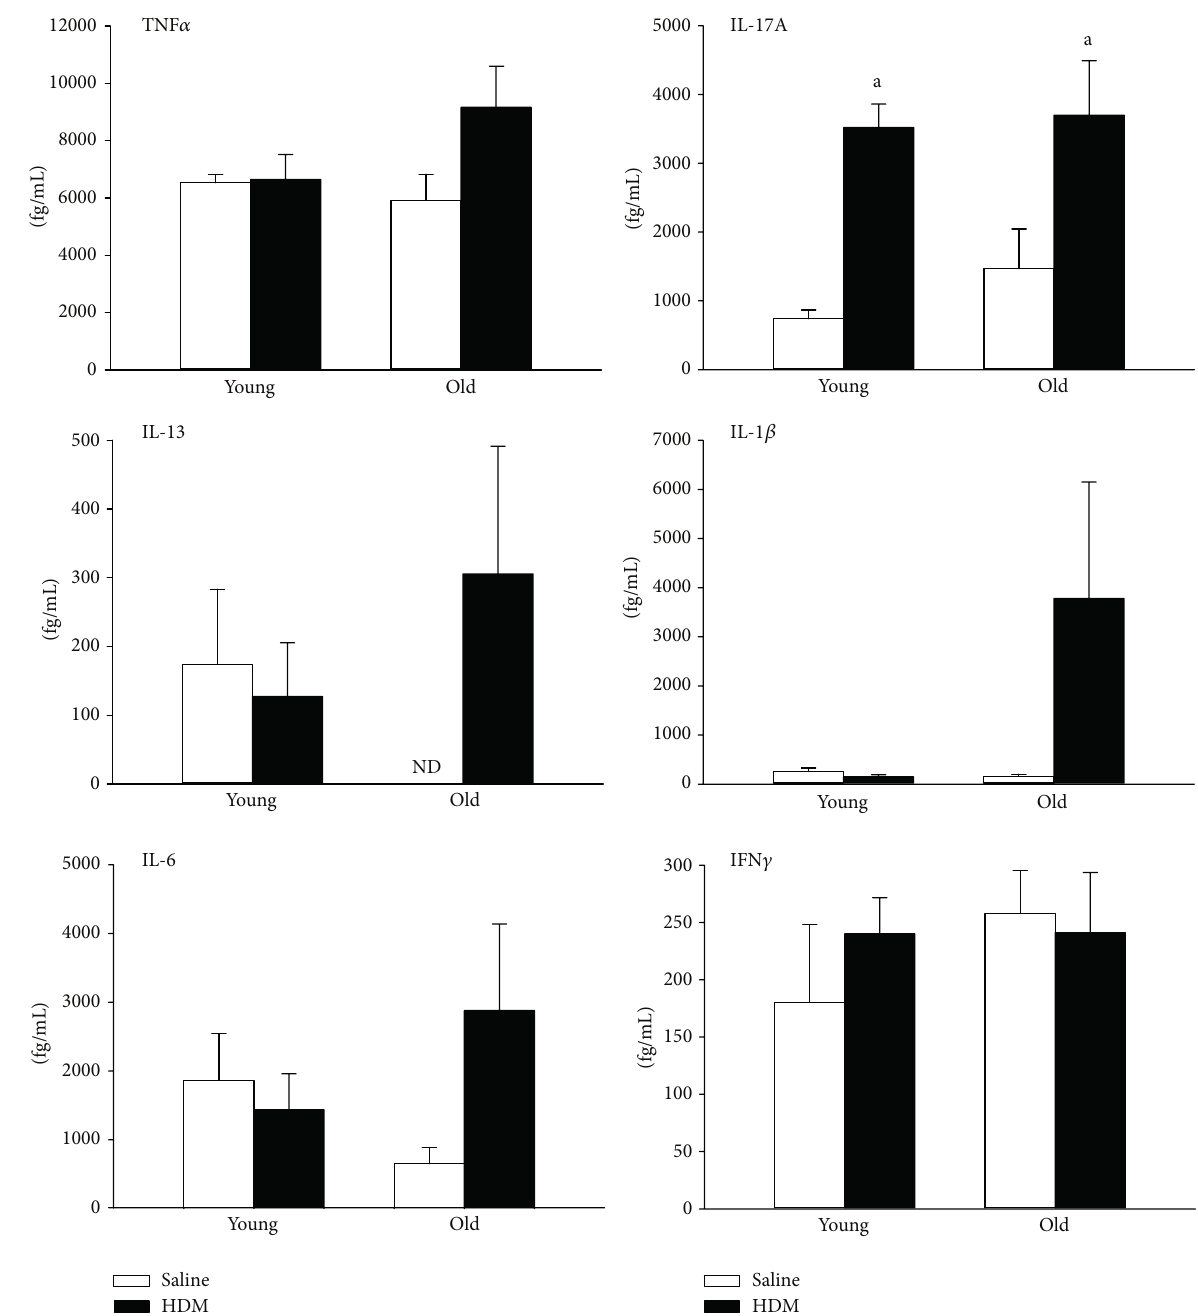
Figure 2: Expression of serum cytokines. Different serum cytokine concentrations were analyzed: TNF 𝛼 , IFN 𝛾 , IL-1 𝛽 , IL-6, IL-13, and IL- 17A. a: significant changes ( 𝑝 < 0.05 , 𝑛 = 6-7) when compared to saline mice of the same age group; no significant changes were detected between young and old mice of the same exposure